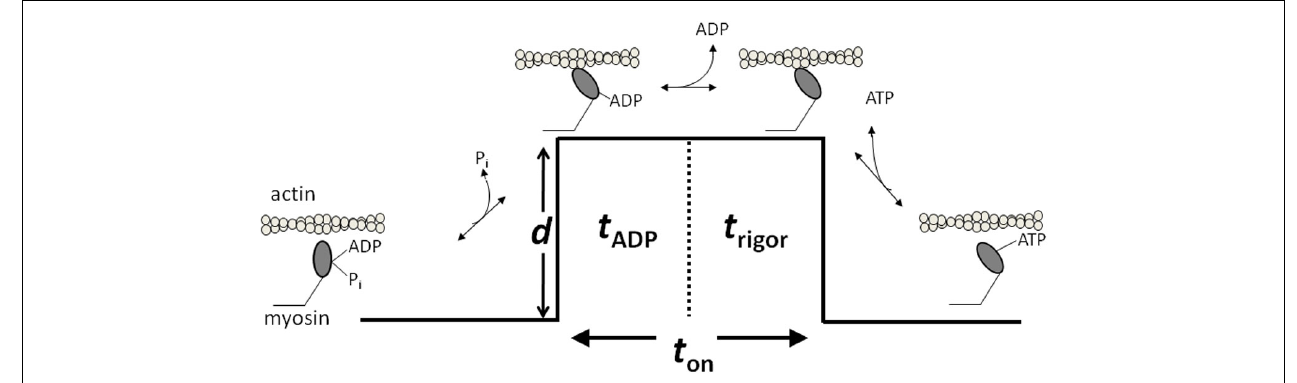
FIGURE 1 |A model of the cross-bridge cycle depicting the biochemical mechanical events. d indicates the powerstroke that causes the displacement. t on refers to the duration of strong actomyosin strong-binding.